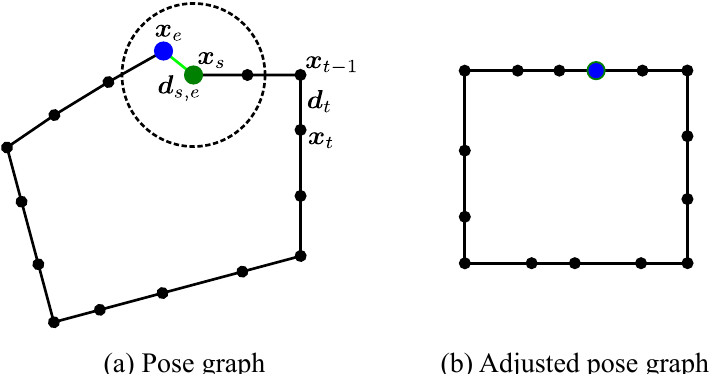
Figure 8. Pose graph. ( a ) The pose graph has the robot’s pose x t in the world coordinate as the vertex and the relative pose d t = [ x (cid:48) t , y (cid:48) t , θ (cid:48) t ] between x t − 1 and x t in the fixed coordinate as the edge. ( b ) On the pose graph, the loop closure is carried out by matching the end point x e of the loop to the start point x s